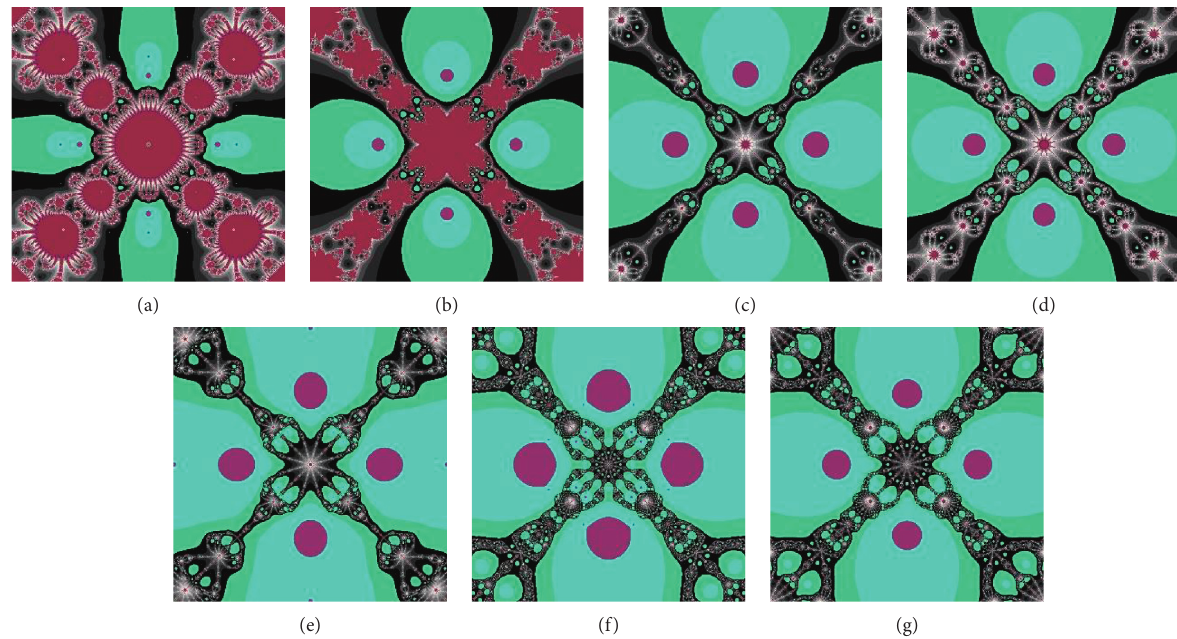
Figure 5: Polynomiographs for the polynomial p NR1. (b) Polynomiograph for the polynomial p